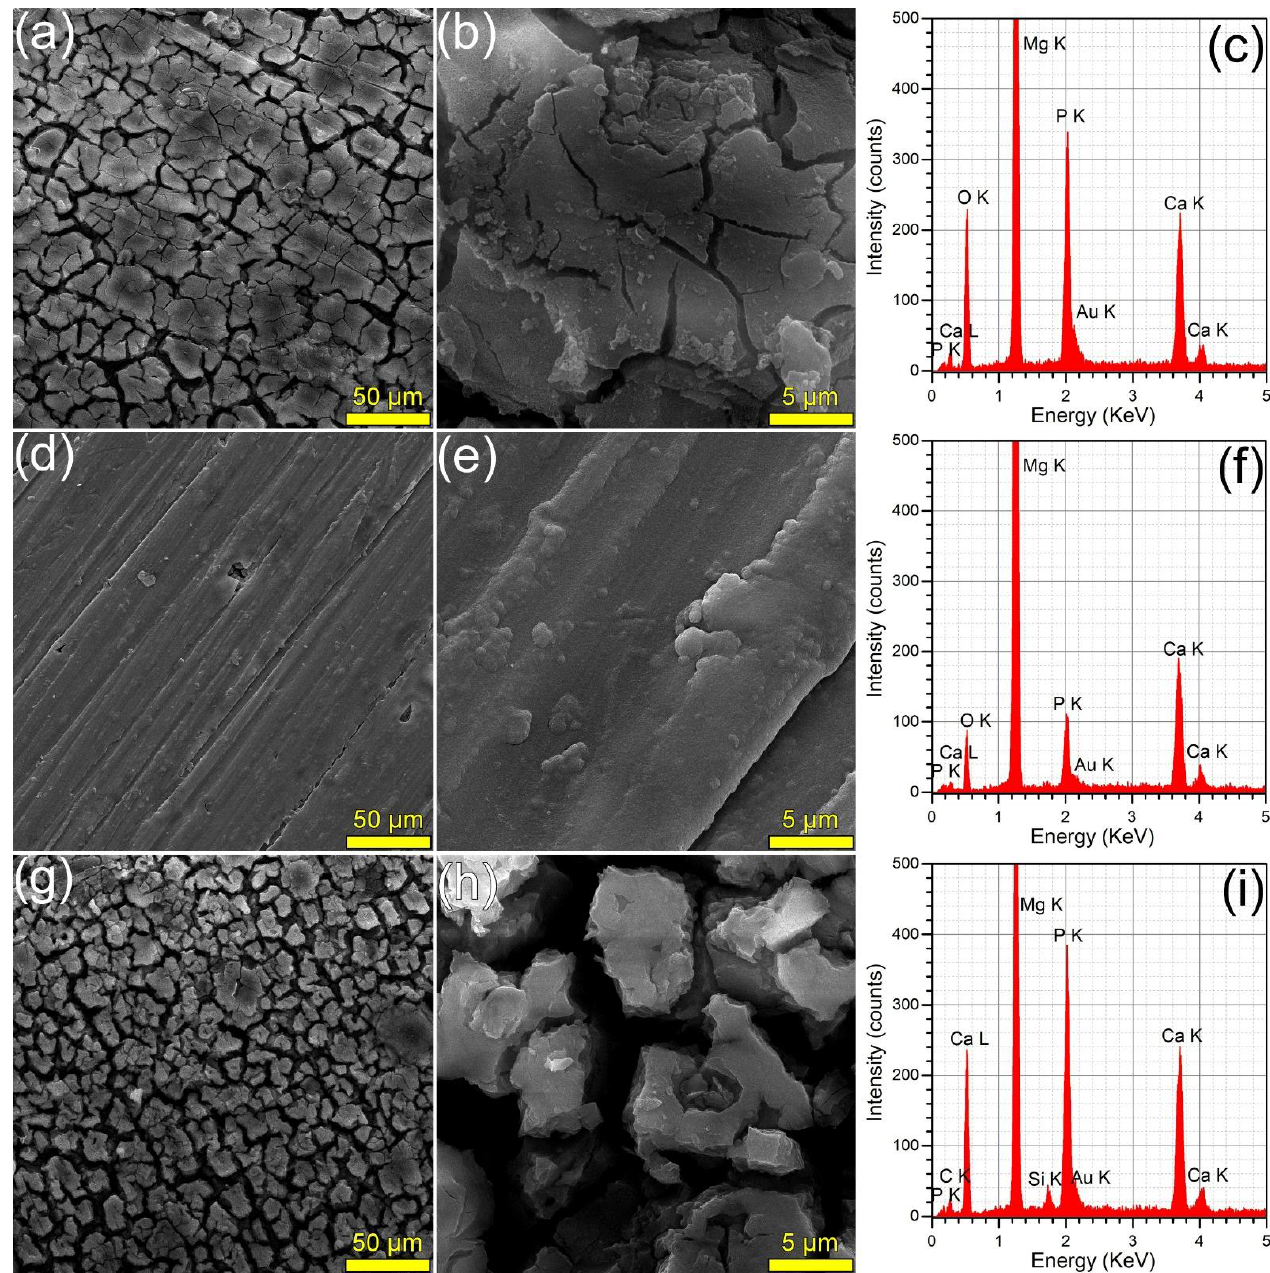
Figure 9. ( a , b , d , e , g , h ) SEM images and ( c , f , i ) EDS spectra collected subsequent to the corrosion tests performed in SBF, on the ( a – c ) bare and ( d – f ) HA2- and ( g – i ) BG2-coated Mg-0.8Ca specimens.